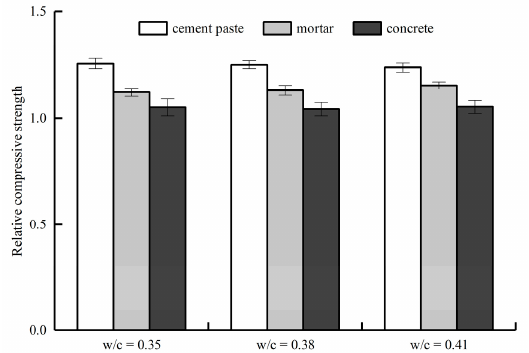
Figure 4. Relative compressive strength of cement paste, mortar, and concrete.